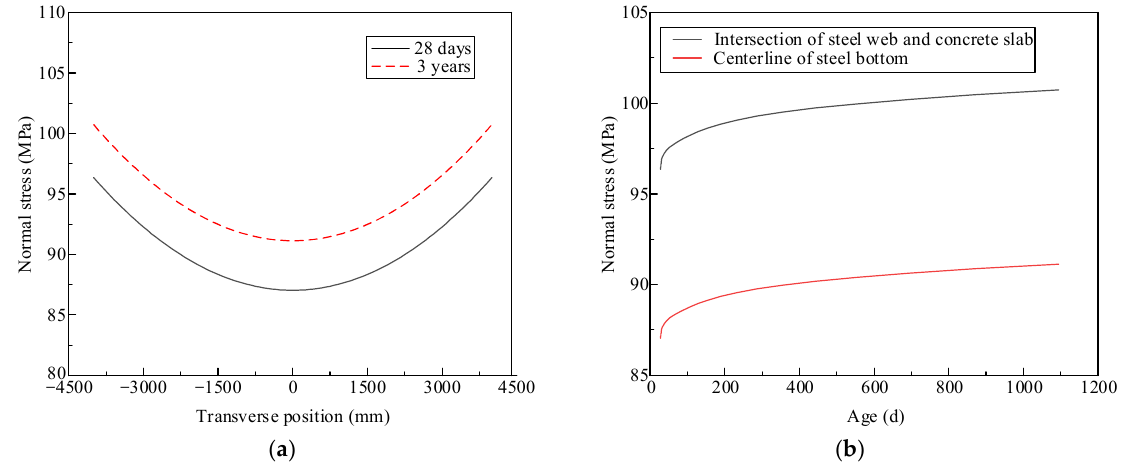
Figure 18. Stress at the bottom flange of the steel beam of the composite beam (time-dependent analysis). ( a ) Distribution along width; ( b ) Change with time at mid-span section. To better show the time-dependent influence, the composite beam on the 3650th day was analyzed. Figure 19 shows the stress distribution on the concrete slab on the 28th and 3650th days. Figure 20 shows the stress distribution at the steel bottom on the 28th and 3650th days. The stress on the concrete slab decreases over this period (28th to 3650th day), and the stress at the bottom flange of the steel beam increases. These results indicate that the creep of concrete produces an unloading effect on the concrete slab.